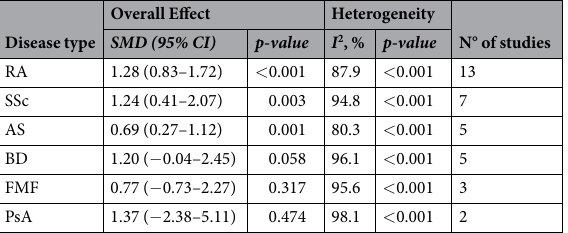
Table 2. Pooled standard mean difference according to rheumatic disease type. SMD, standard mean difference. RA, rheumatoid arthritis; SSc, systemic sclerosis; AS, ankylosing spondylitis; BD, Behcet’s disease; FMF; familial Mediterranean fever; PsA, psoriatic arthritis.